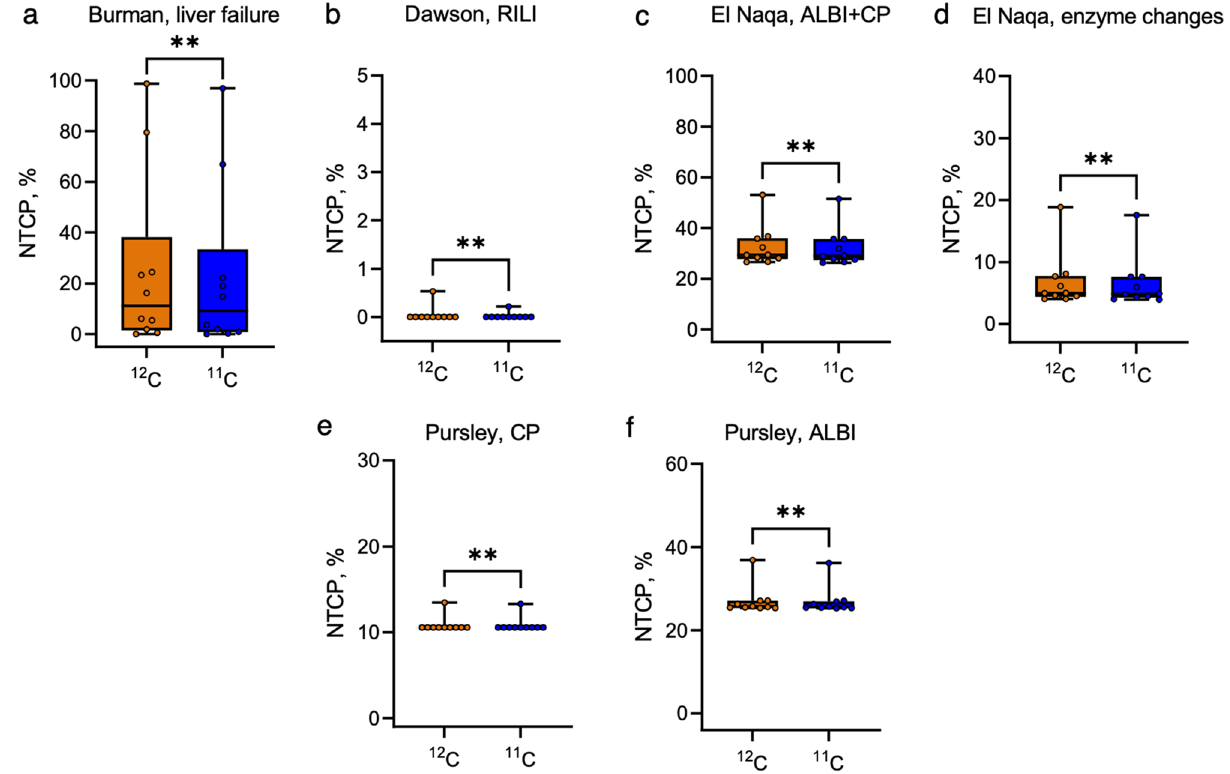
Figure 5. Normal tissue complication probability estimations for liver tumor patients estimated for each patient using the LKB parameters from six different models. ( a ) Burman model for the endpoint of liver failure, ( b ) Dawson model for the endpoint of radiation-induced liver injury (RILI) grade > 3, ( c ) El Naqa model for changes in ALBI and CP scores, ( d ) El Naqa model for enzymatic changes, ( e ) Pursley model for changes in CP score, ( f ) Pursley model for changes in ALBI score. Single points correspond to the patient-specific median NTCP values. Orange and blue bars correspond to the predictions for 12 C and 11 C plans, respectively. Stars represent the result of the Wilcoxon Signed-Rank test ( P = 0.002 for a – d and F, P = 0.0039 for e